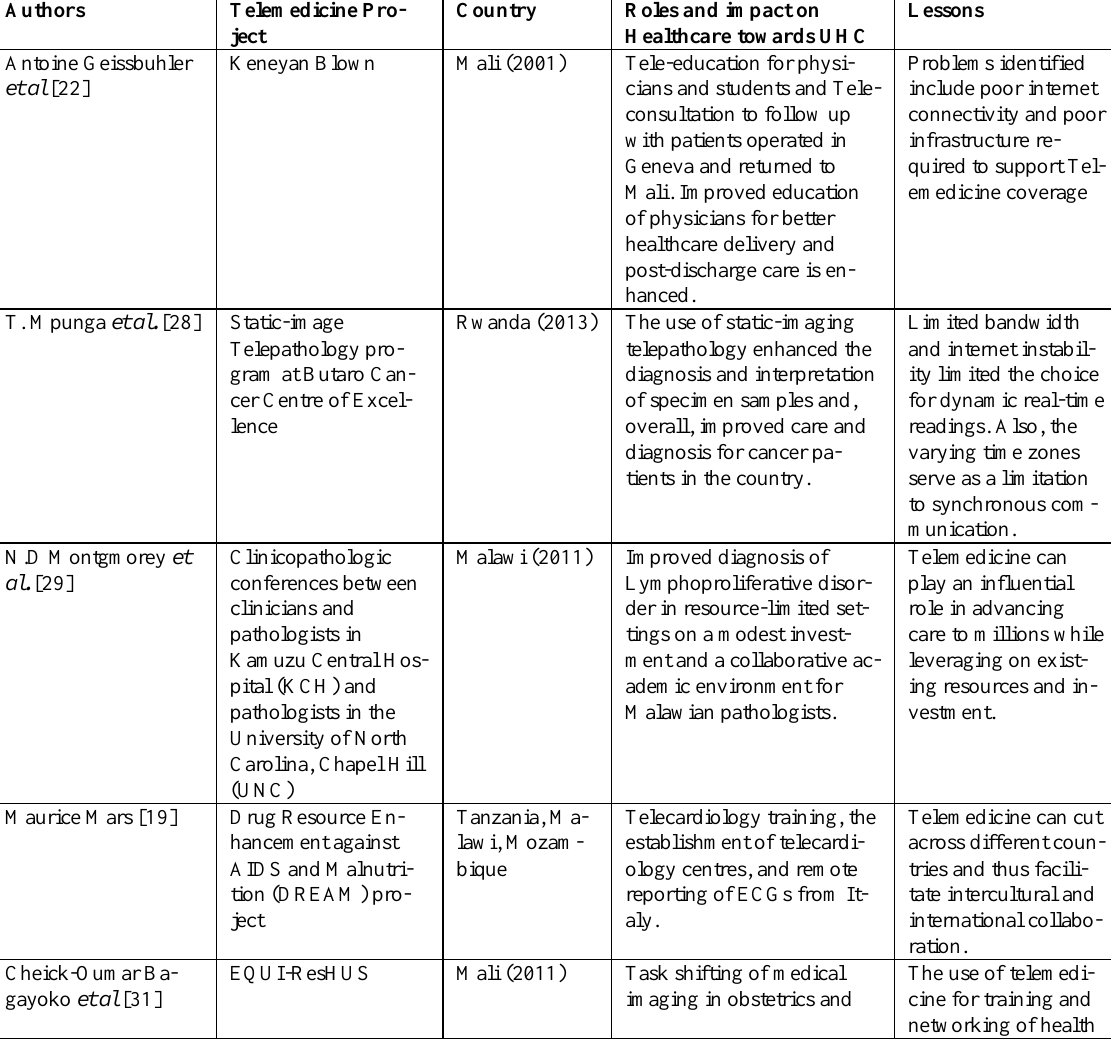
Table 1: Various Telemedicine Projects and approaches and Impact towards achieving Universal Health Coverage in